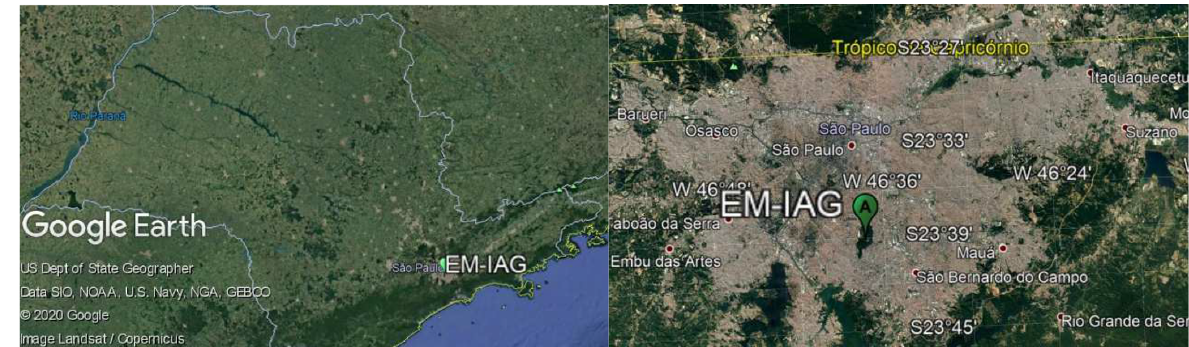
Figure 1. São Paulo state and a zooming in view of São Paulo metropolitan area and the location of the meteorological station of Instituto de Astronomia, Geofísica e Ciências Atmosféricas from Universidade de São Paulo (EM-IAG). Adapted from © Google Earth (US Dept. of State Geographer – Data SIO, NOAA, U.S. Navy, NGA, GEBCO – Image